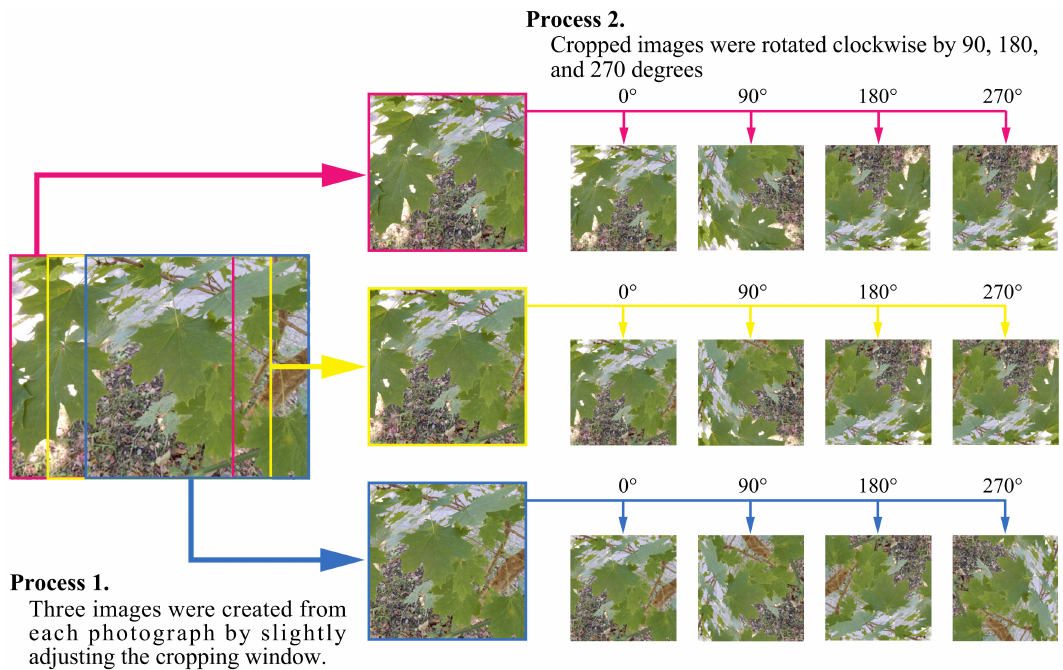
Figure 2. Methods for creating leaf images from